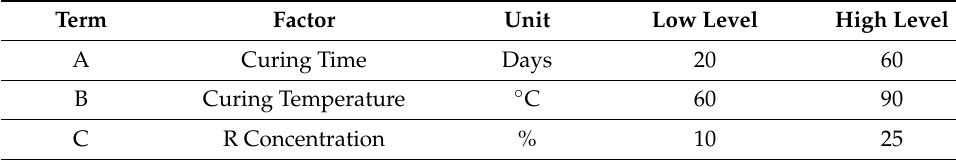
Table 4. Parameters for design of experiments.